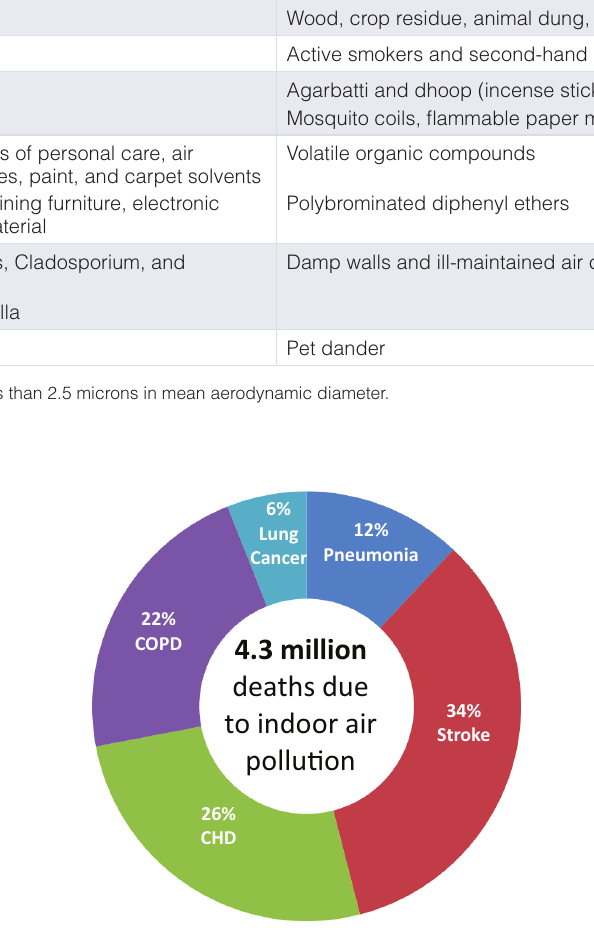
Figure 5. Deaths related to indoor air pollution. CHD, coronary heart disease; COPD, chronic obstructive pulmonary disease.